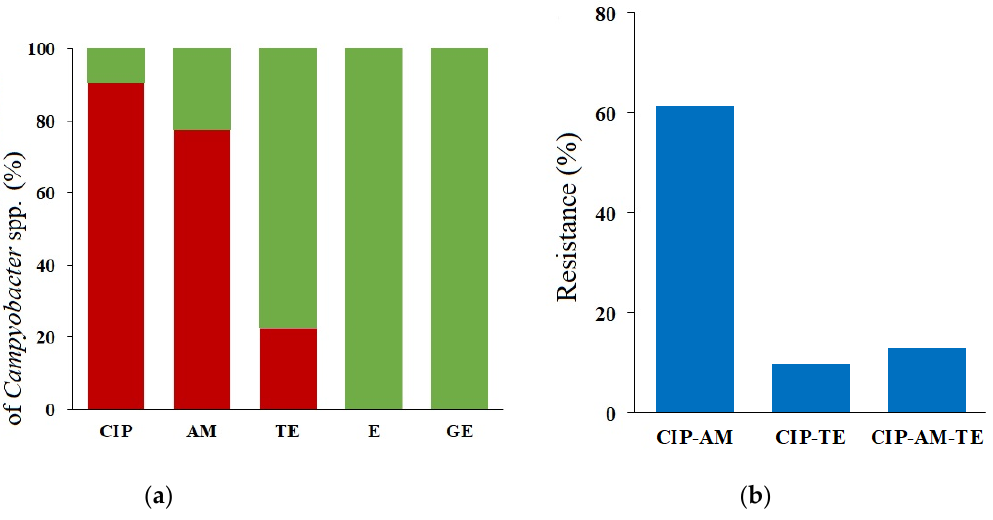
Figure 1. Summary of antimicrobial resistance testing: ( a ) Diagram showing level of susceptibility and resistance to antimicrobial agents, green—susceptible; red—resistant; CIP—ciprofloxacin; TE— tetracycline; AM—ampicillin; E—erythromycin; GE—gentamicin; ( b ) Percentage of resistance to two or more classes of antimicrobials. Table 1. Frequency of occurrence of the AMR patterns obtained in this study.